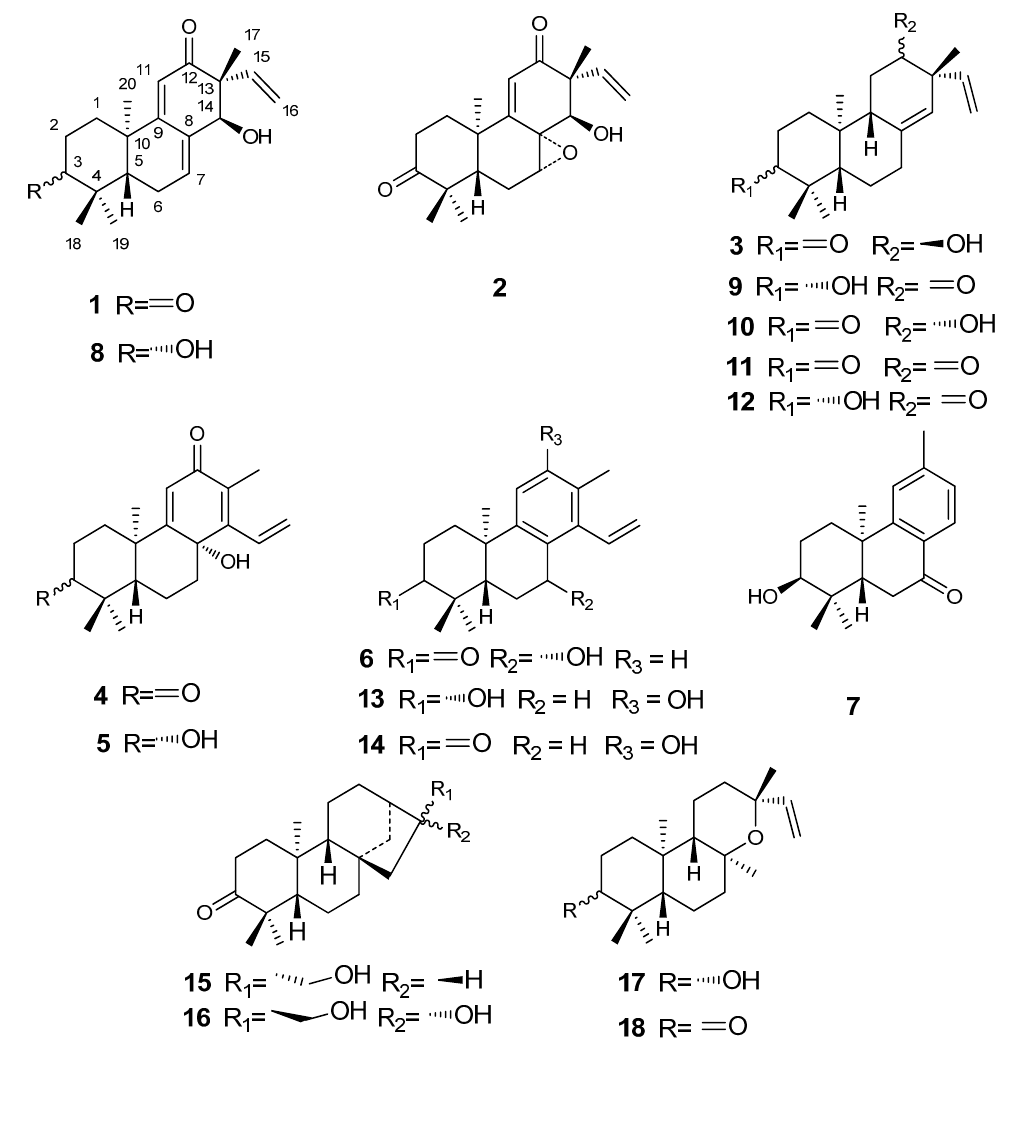
Figure 1. Chemical structures of compounds 1 – 18